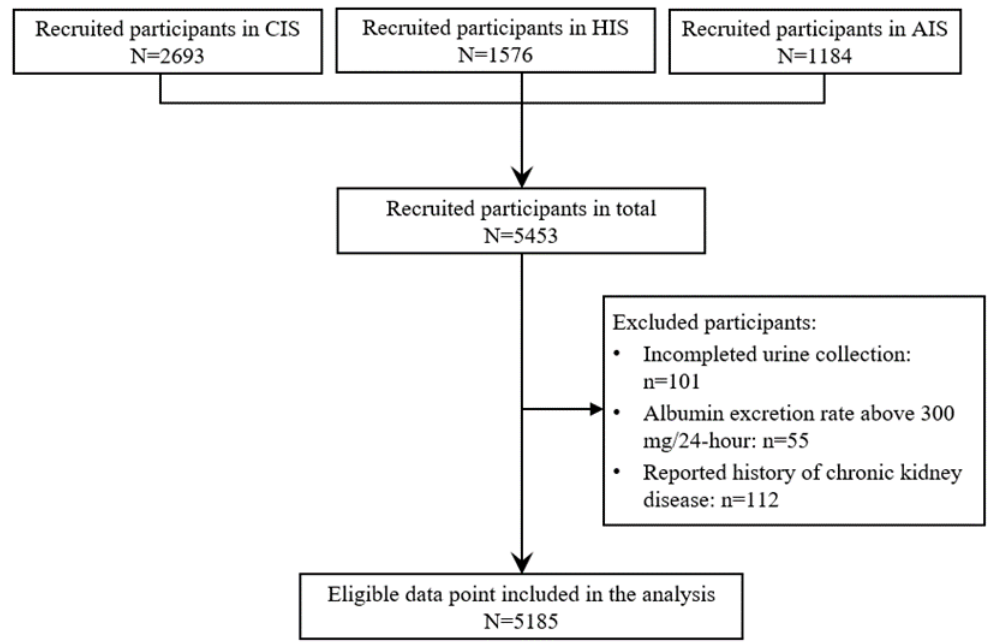
Figure 1. Flowchart of participants. Notes: Community-based comprehensive salt reduction intervention study (CIS), Home cook salt reduction intervention study (HIS) and App-based salt reduction in primary school children and their families (AIS) are the 3 independent trials in Action on Salt China program.